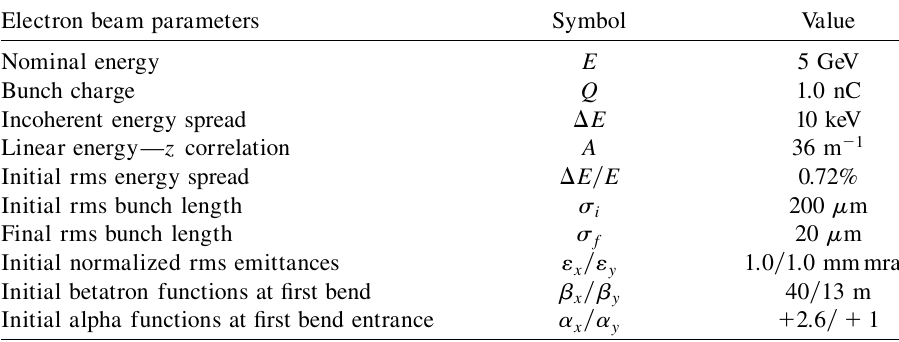
e -beam parameters used in the benchmark.